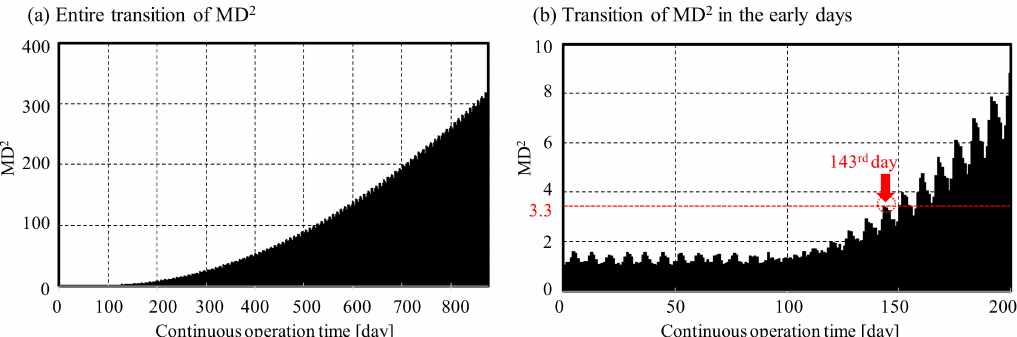
Figure 26. Transition of MD 2 in the simulated time-series data ( a ) over the entire 870 days and ( b ) during the early 200 days of operation: As shown in Figure 26a, the value of MD level changes from the normal state to the anomaly state. At the 143rd day from the beginning of the 2 data in Figure 26b, MD exceeds the threshold value of